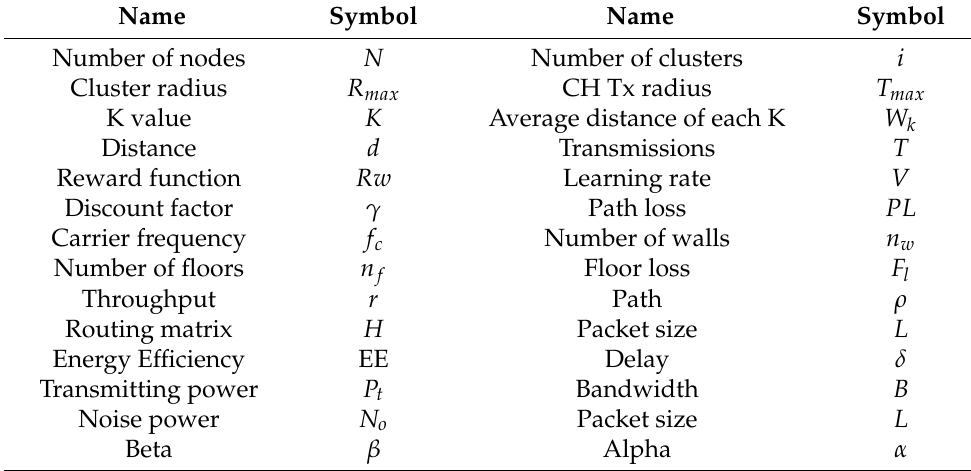
Table 1. Table of symbols.